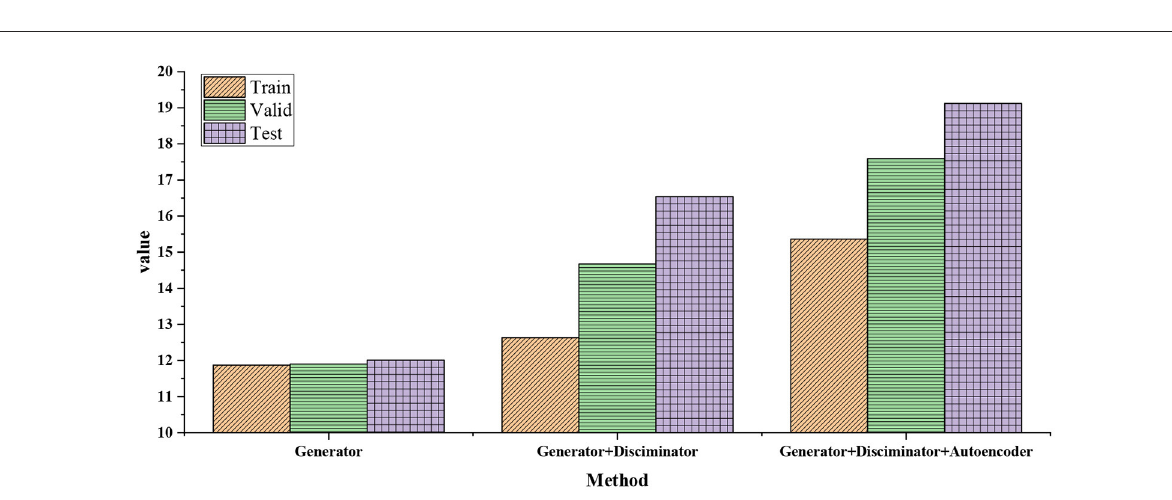
FIGURE8 Impact of different modules on model loss in model building